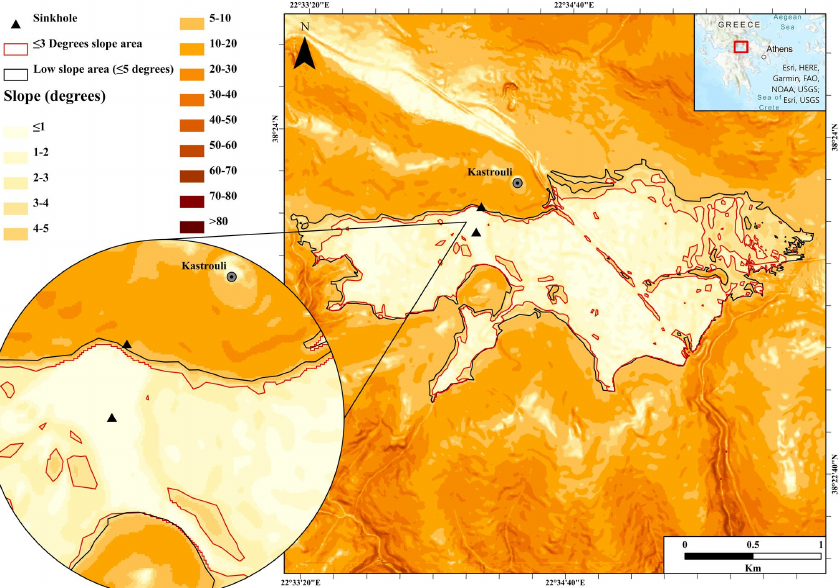
Figure 12. Morphological slopes of Kastrouli area. The black outline identifies the area with incli- nations fluctuating between 0 and 5 degrees (0 and 8.75%). On the contrary, the wide red outline indicates an area of 2.33 Km 2 , with inclinations fluctuating between 0 and 3 degrees (0 and 5.24%). Gray triangles are the